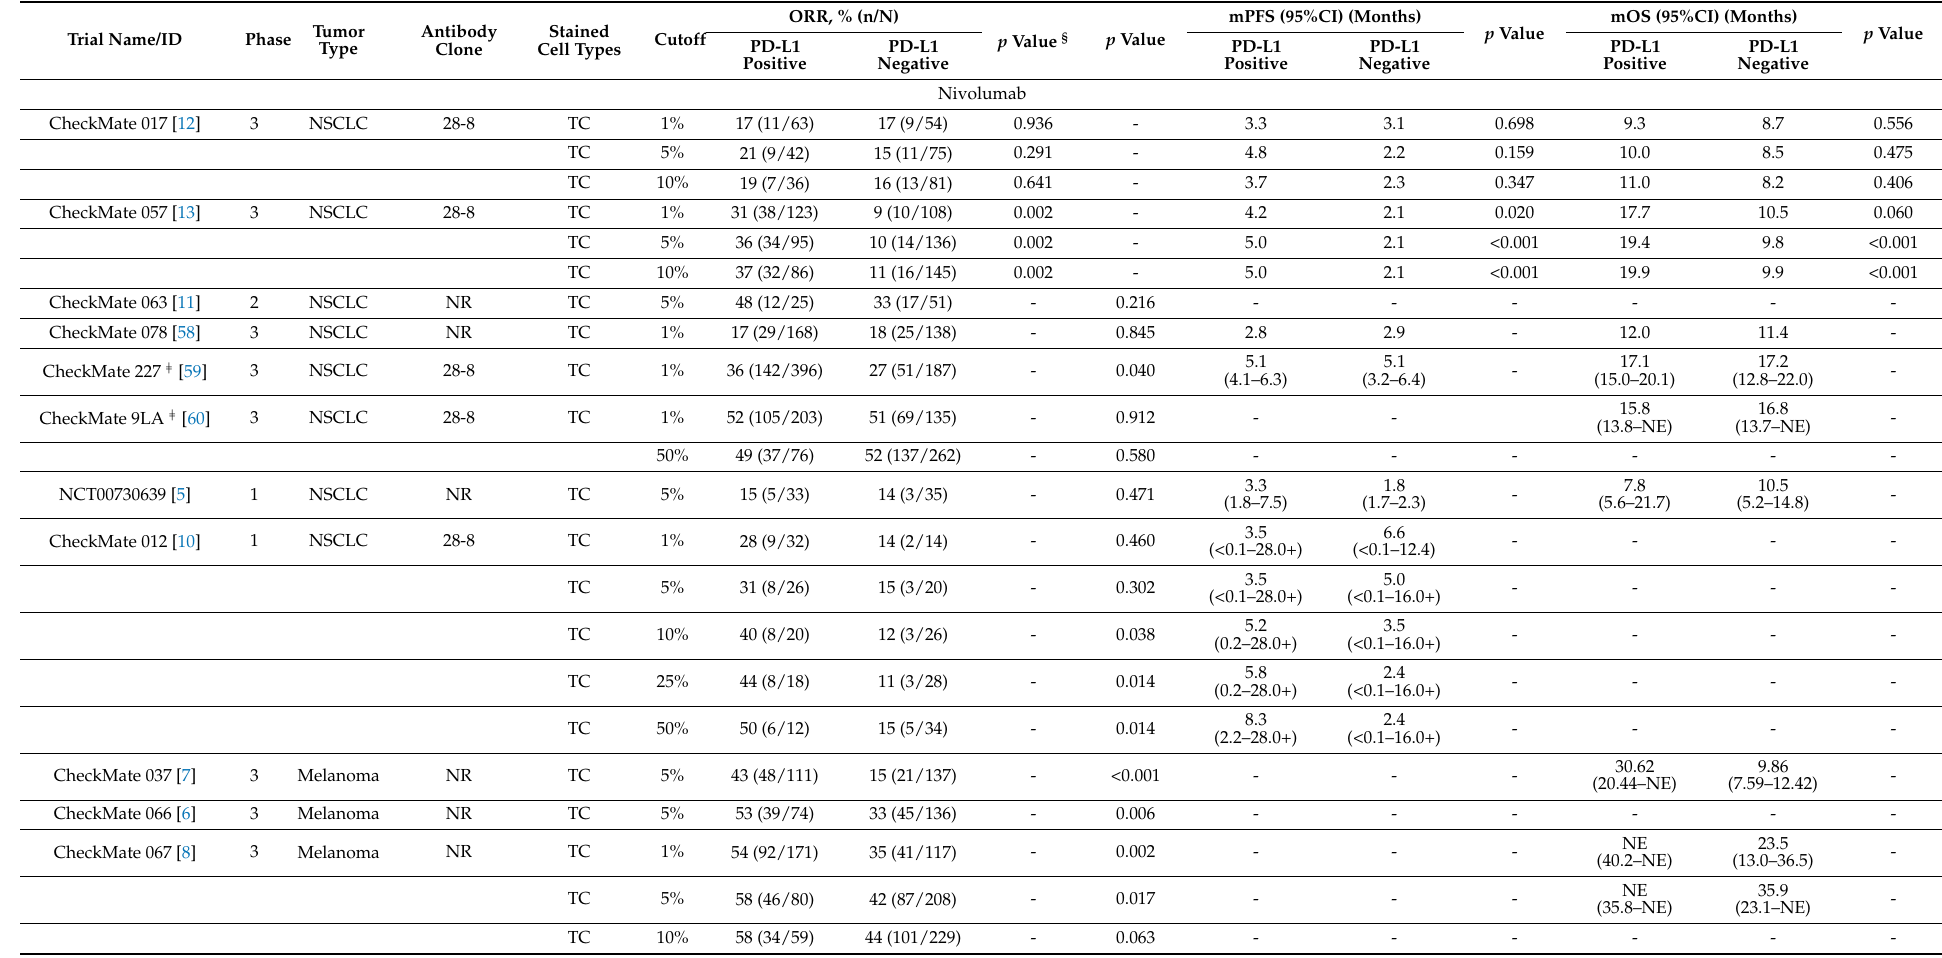
Table 1. Summary of PD-L1 expression and associations with response rate and survival benefit of PD-1/PD-L1 inhibitors in clinical